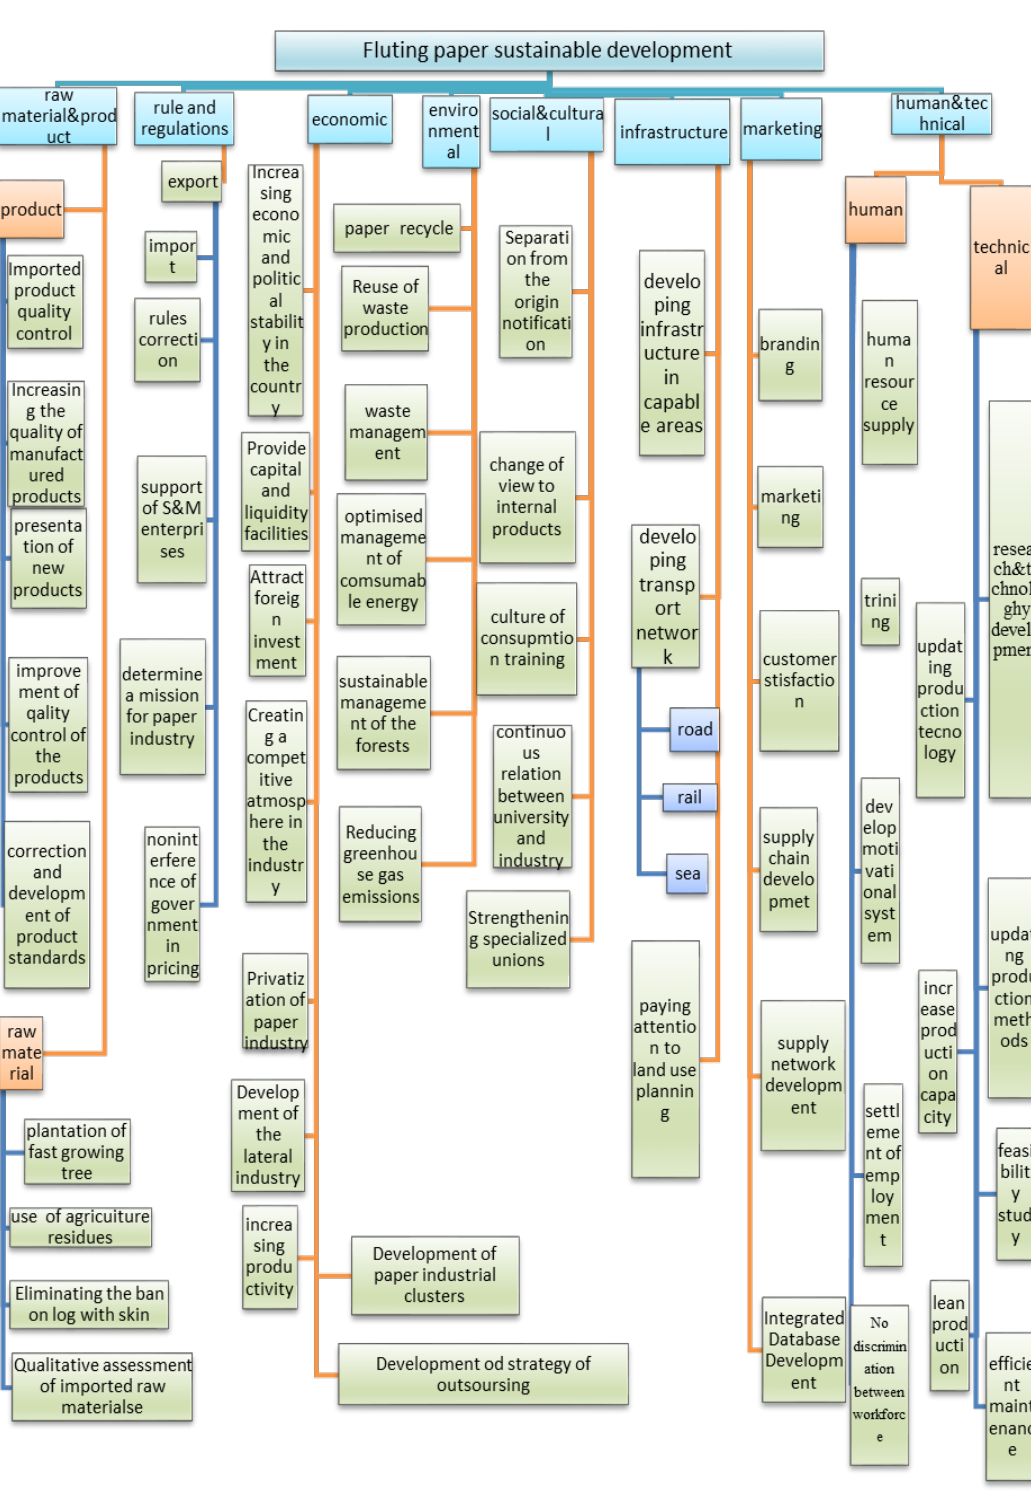
Figure 3: A hierarchy model of criteria and sub